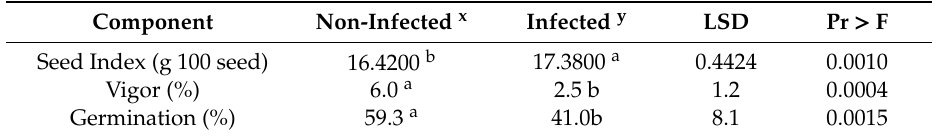
Table 1. The comparison of non-infected (non-symptomatic) compared to infected soybean seed for Seed Index, vigor, and germination. The field experiment was conducted in 2019 at the Delta Research and Extension Center in Stoneville,